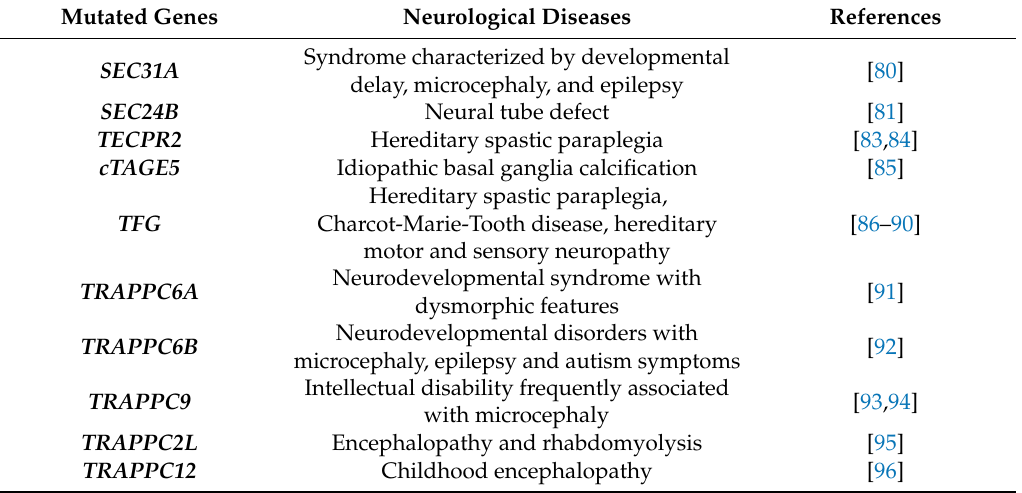
Table 1. Genetic mutations a ff ecting the ER-to-Golgi tra ffi cking machinery in neurological